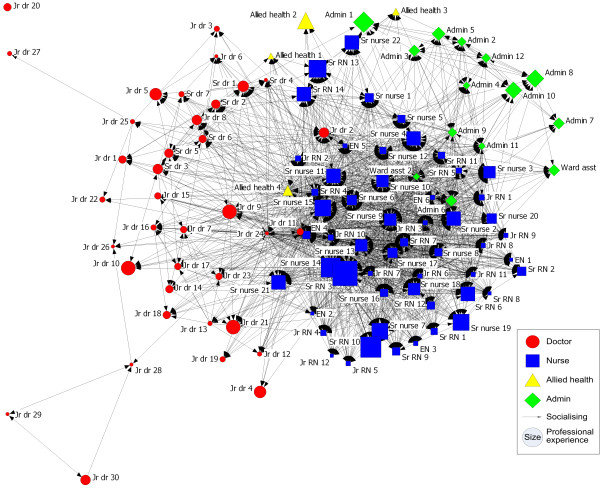
Socialising network.